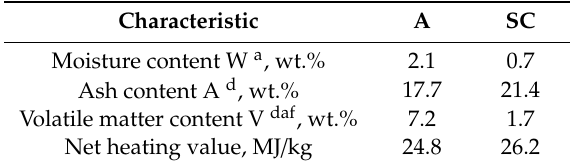
Table 1. Characteristics of the anthracite (A) and its semi-coke (SC) samples. Characteristic A SC Moisture content W a , wt.%